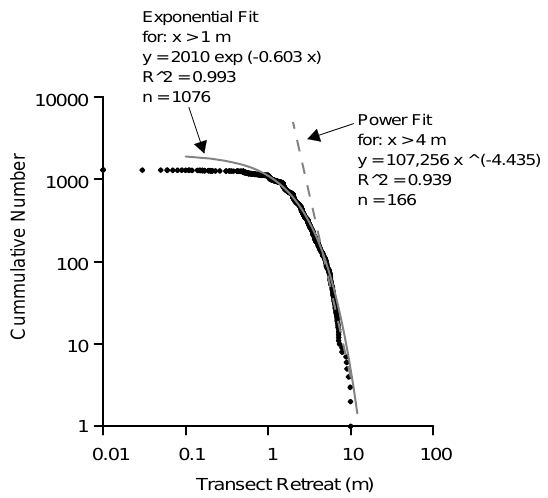
Fig. 10. Log of cumulative number of transect retreats versus log of transect